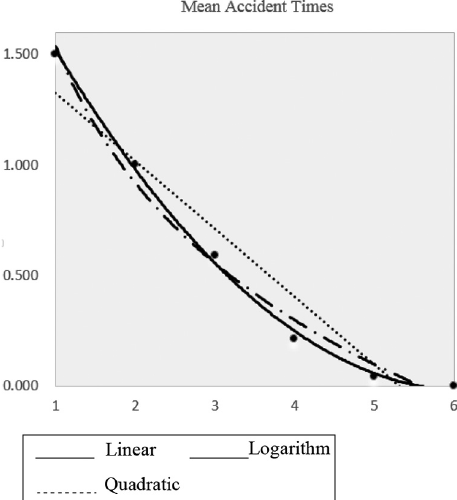
Figure 1. The fi tting graph of driving behaviors scores and